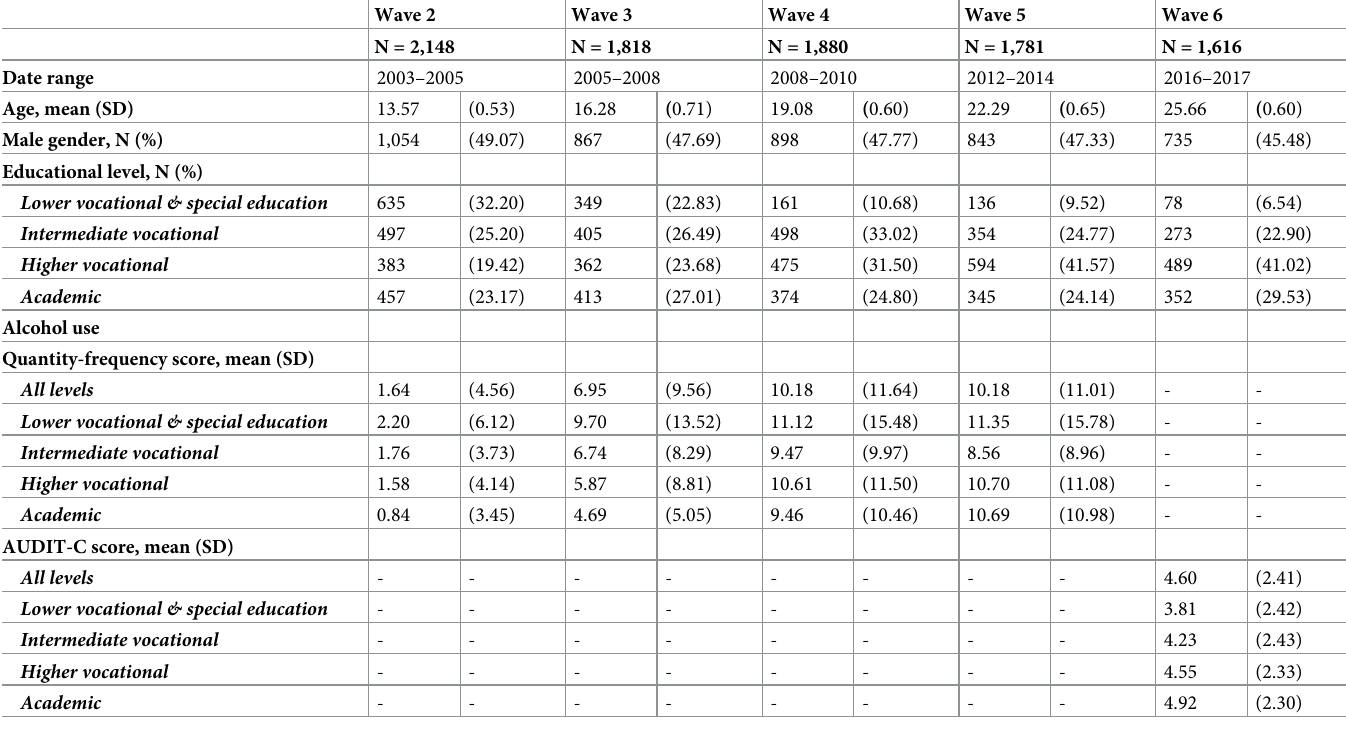
Table 2. Alcohol use of adolescents and young adults participating in the TRAILS Study (the Netherlands, 2000–2017, N = 2,229) according to concurrent educa- tional